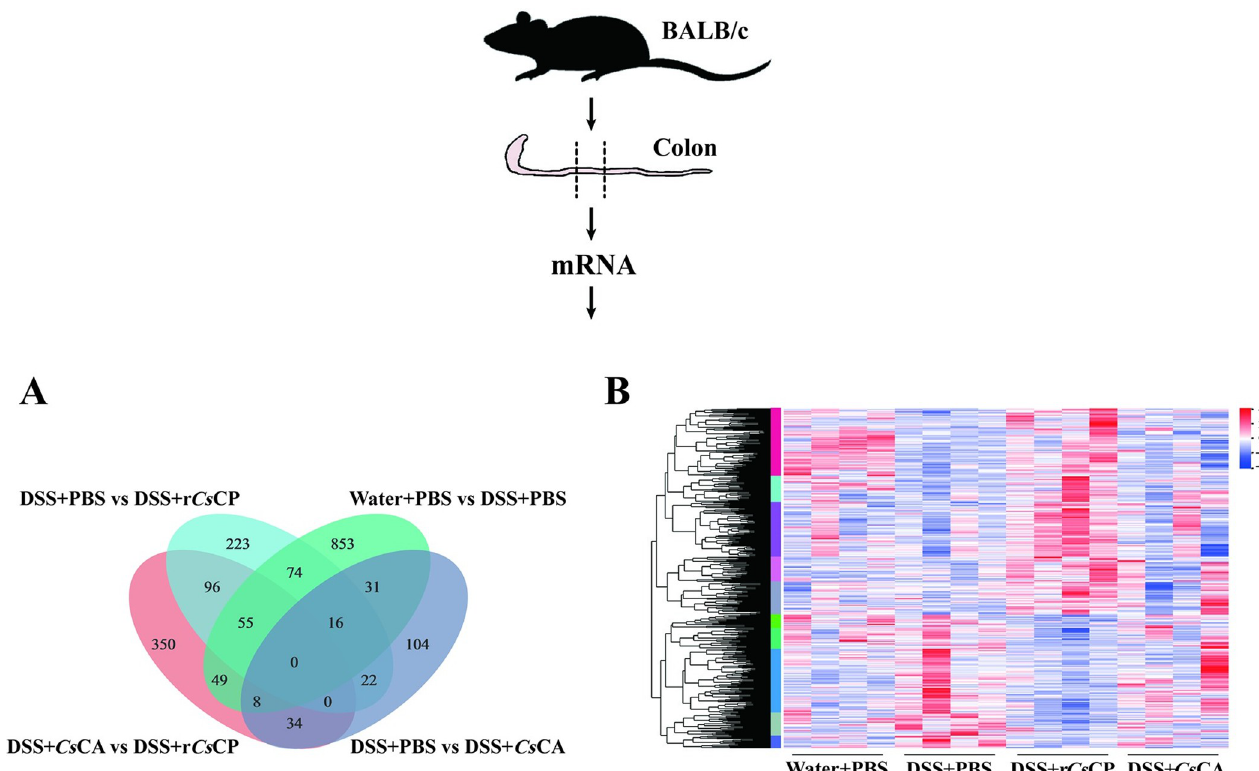
Fig 6. Changes of colonic transcriptome in DSS-induced colitis mice after r Cs CP or Cs CA treatment (n = 4). (A) Venn diagram of colonic DEGs among four groups of Water+PBS, DSS+PBS, DSS+r Cs CP and DSS+ Cs CA. (B) Heatmap of colonic gene expression levels in four groups. Each column represents a sample, and each row represents a gene. Red and blue indicate gene up- and down-regulation, respectively.